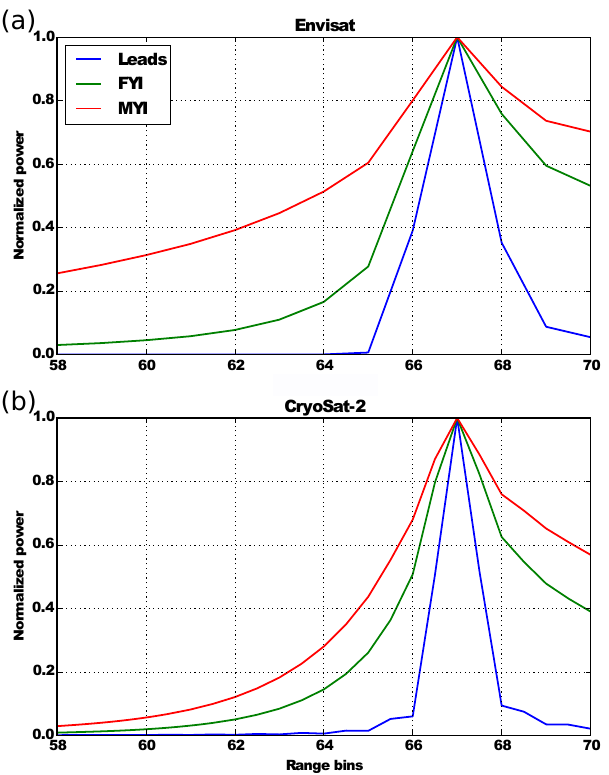
Figure 2. (a) Envisat and (b) CryoSat-2 mean waveform echoes for leads (blue), FYI (green) and MYI (red) calculated during the 2010/11 winter and for the entire common flight